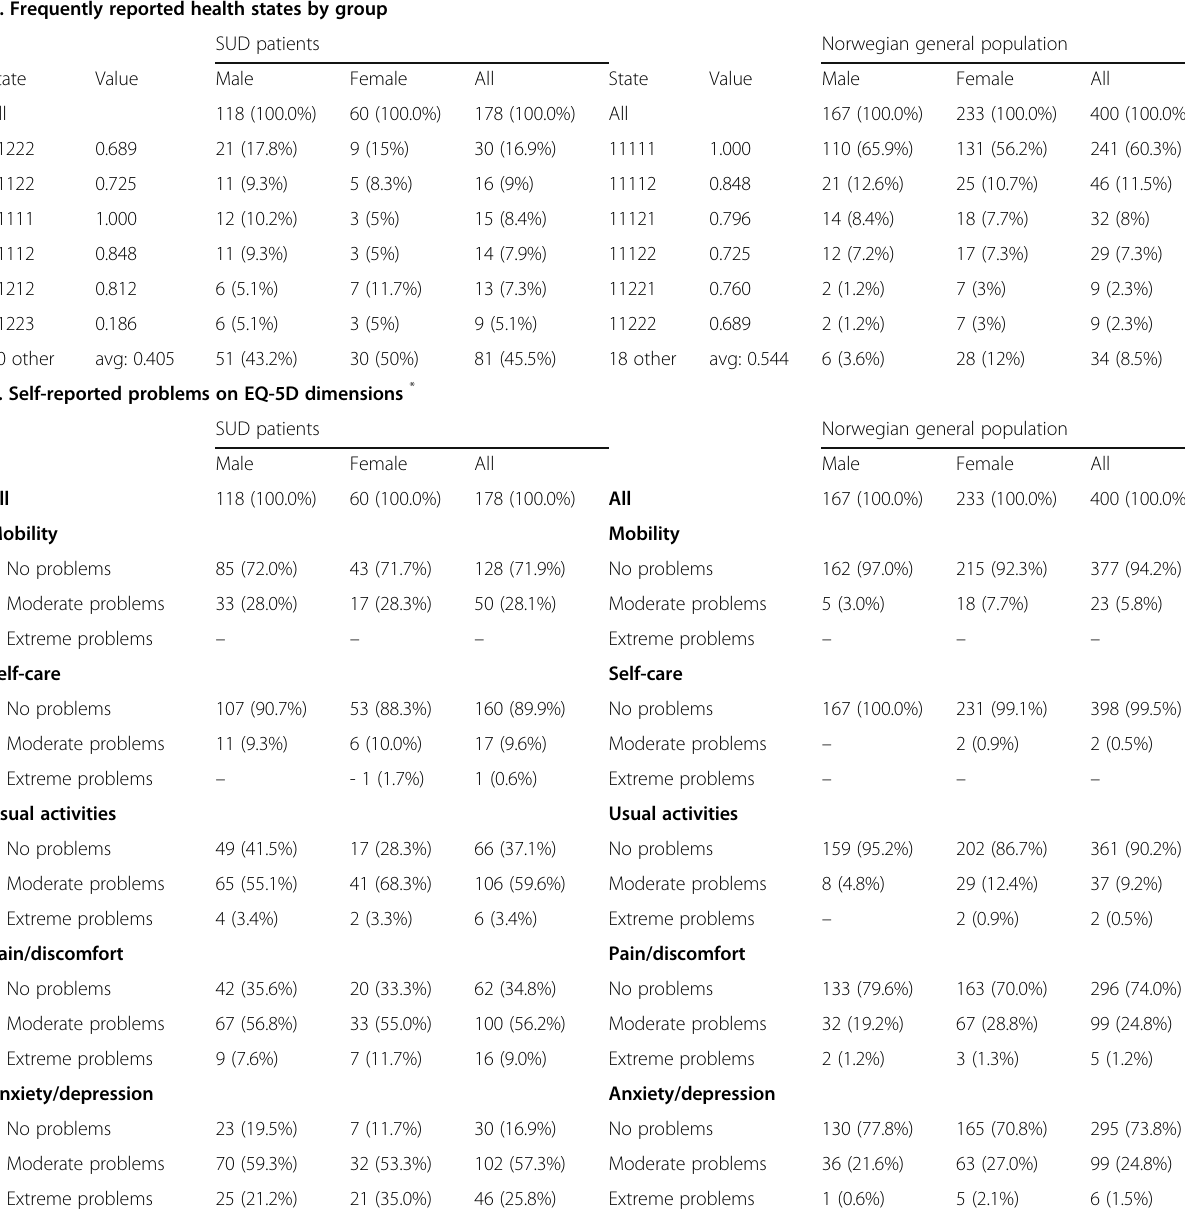
Table 2 Self-reported EQ-5D-3L health state characteristics by SUD patients and Norwegian general population samples, n